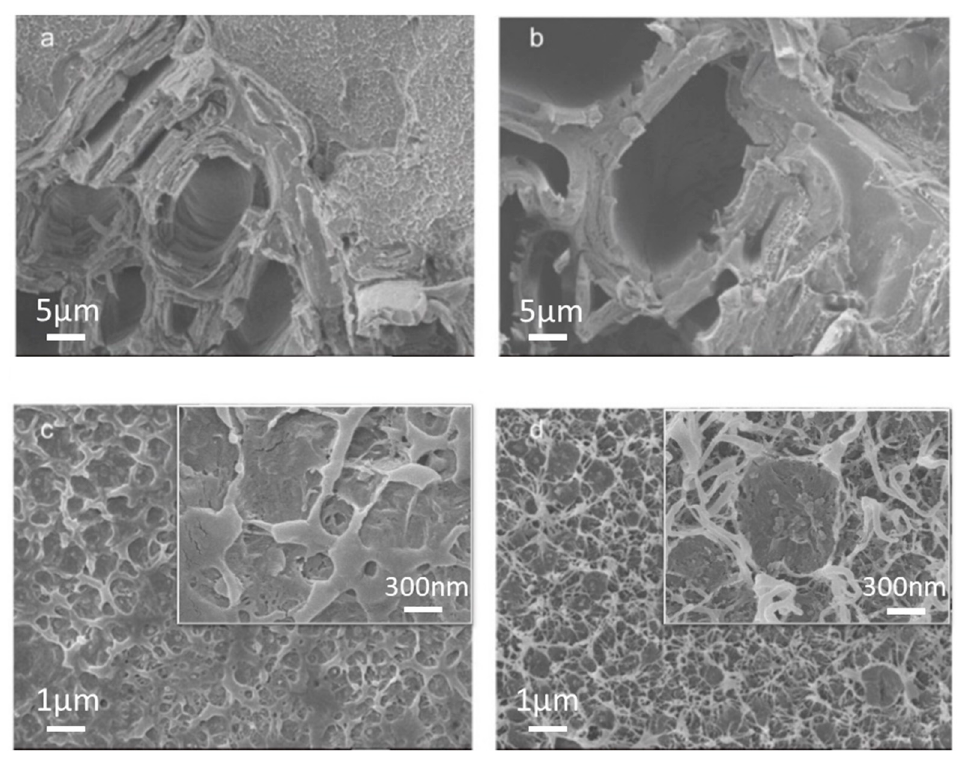
Figure 5. SEM images of original biocomposites (MWPC0) ( a , c ); magnetic biocomposites (MWPC20) at different magnifications ( b , d ).